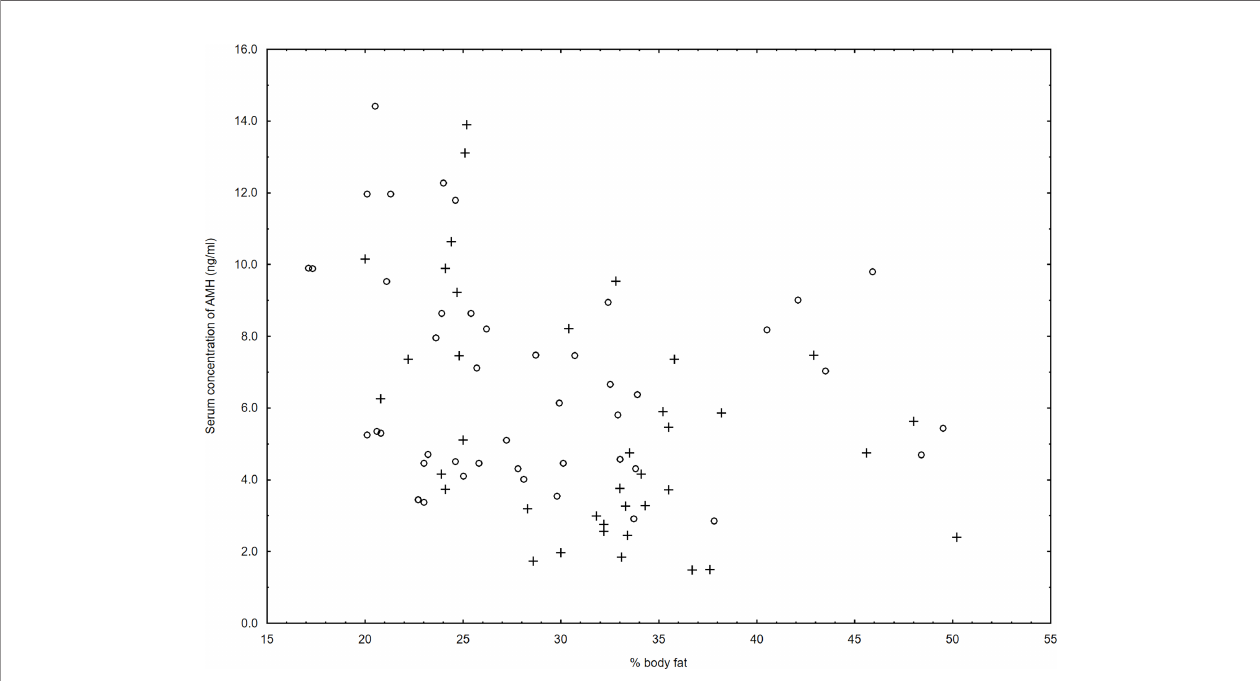
FIGURE 1 | Relationship between serum levels of AMH and % body fat in the women with Hashimoto thyroiditis (r=-0.38, p=0.03) (+) and in the control group (r=-0.19, p=0.14) ( ○ ).